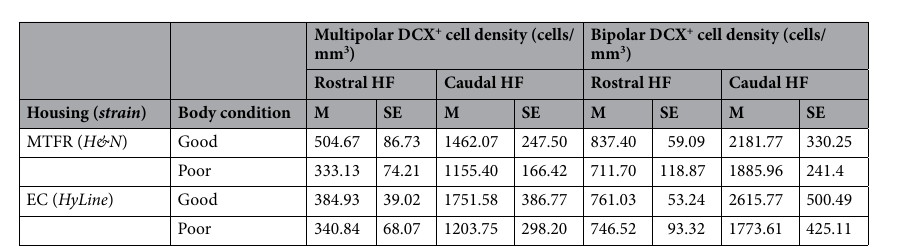
Figure 4. Mean densities of cells expressing doublecortin (DCX) with ( a ) multipolar, and ( b ) bipolar (or fusiform) morphology, in the rostral and caudal hippocampal formation (HF) subregions of H&N (n = 12) and Hy-Line (n = 12) strain laying hen pullets (14 weeks old). Error bars display + 1 standard error. Cell densities are normalized within staining batches and subregion of the HF (rostral/caudal) using the standard score ( Z i ). The figure therefore does not allow a direct comparison between the two HF subregions, only between strains within subregion. Raw densities were higher in the caudal HF than the rostral HF for DCX + multipolar ( p < 0.001) and bipolar ( p = 0.021) cells (see “Adult Hippocampal Plasticity” section). Cell densities did not differ between the strains, and there was no interaction with HF subregion.